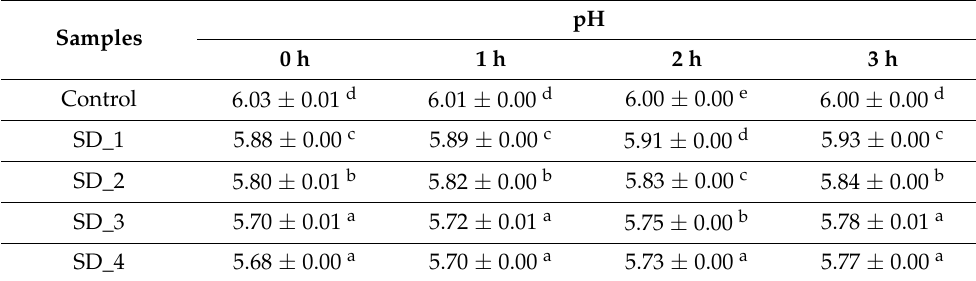
Table 3. pH values of dough samples with different levels of dry sourdough (SD) addition.